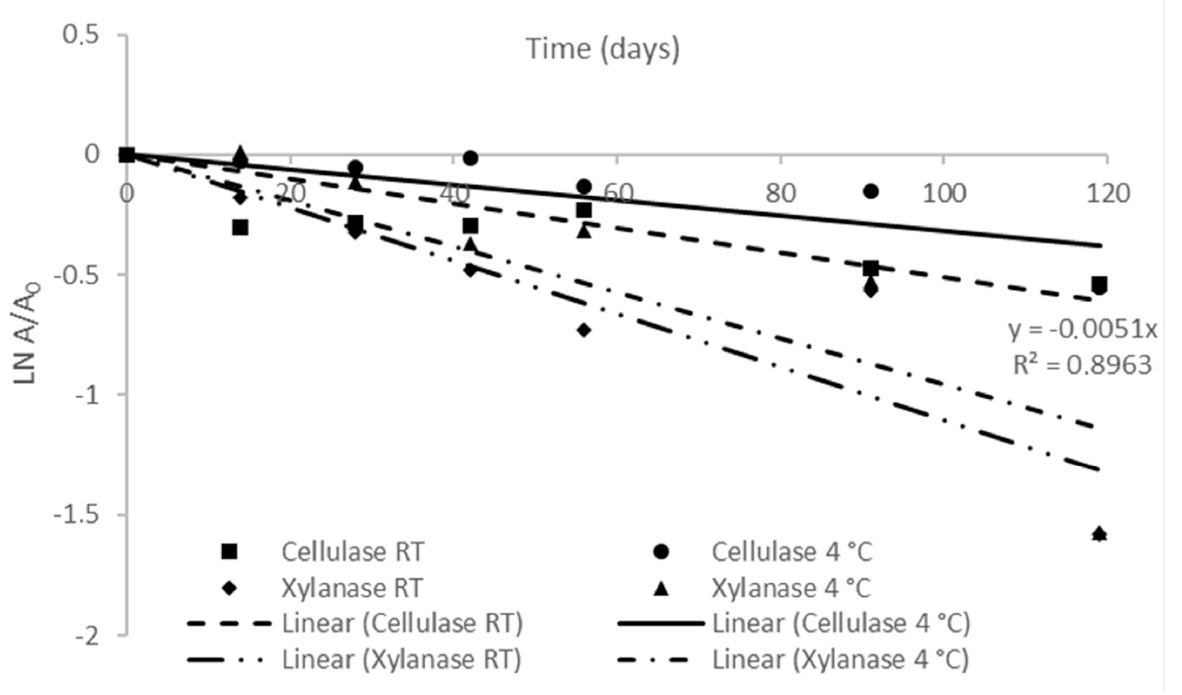
Figure 2. First-order storage deactivation of xylanase and cellulase activity of FBE-supplemented diet at room temperature and 4 °C. The results represent the average of three independent experiments and the error bars represent SD. Table 2. Inactivation kinetic parameters of cellulase and xylanase stored at room temperature and 4 ◦